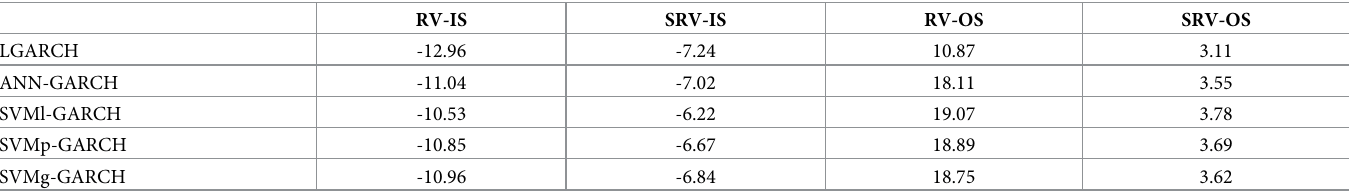
Table 12. QLIKE loss function results for ANN and SVM models. This table reports the QLIKE loss function results for the model performance comparison regarding our model with GARCH models with ANN and SVM. SRV represents the simplified realized variance, IS represents the in-sample results (from year 2000-2010) and OS represents the out-of-sample results (from year 2011-2019). SVMl, SVMp and SVMg represent the SVM with linear, polynomial and Gaussian kernel,